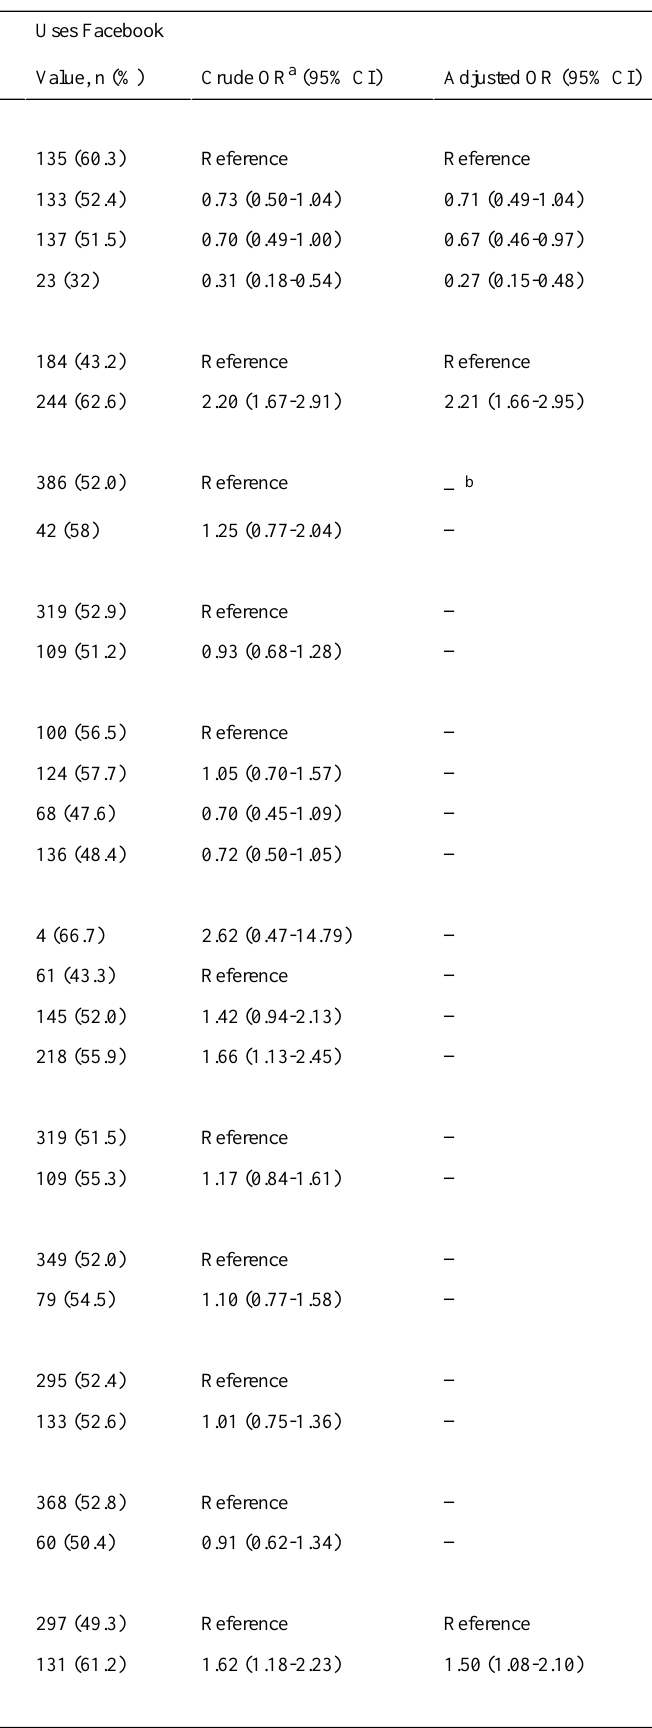
Table 2. Use of Facebook in relation to demographic, clinical, psychosocial, and technology use characteristics of online older adults with atrial fibrillation (N=816), Systematic Assessment of Geriatric Elements in Atrial Fibrillation (SAGE-AF)